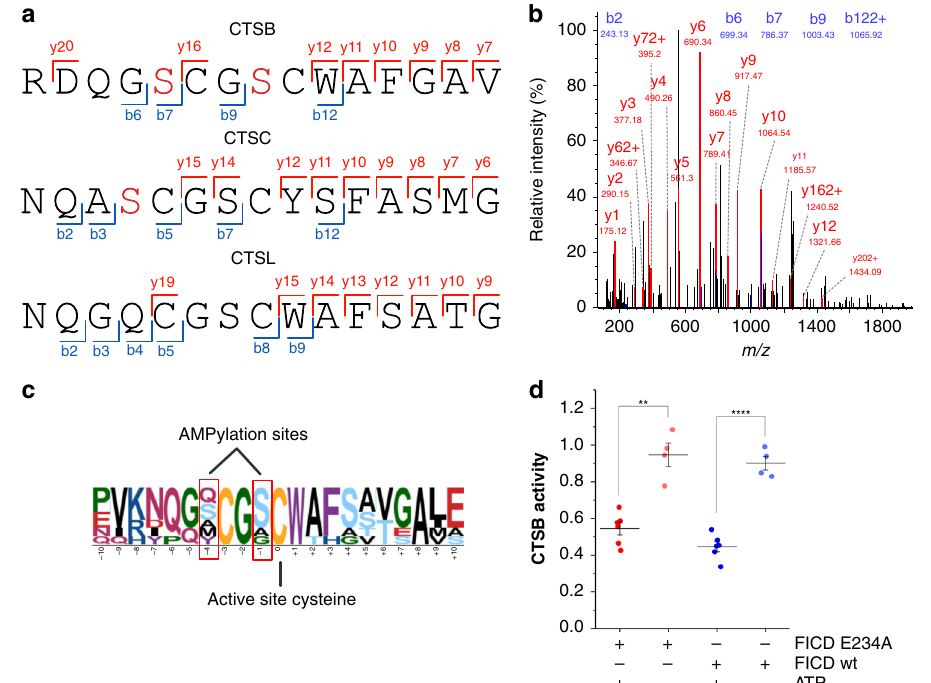
Fig. 2 CTSB peptidase activity is inhibited by FICD catalysed AMPylation. a Identi fi ed AMPylation sites on serine residues (red) of cathepsins B, C and L using pro-N6pA in HeLa cells. b Exemplary MS/MS spectrum (MaxQuant) for the CTSB AMPylation site identi fi cation on S107 (see Supplementary Figs. 4 and 5). c Amino acid motif surrounding the active site cysteine of cysteine cathepsins. d In vitro peptidase assay of CTSB activity after incubation with wt FICD or E234A mutant and with or without ATP for 6 h. Normalised to CTSB activity without FICD protein. Lines represent the mean and whiskers stand for 25th and 75th percentile. Two-tailed Student ’ s t -test; ** P < 0.01, **** P <